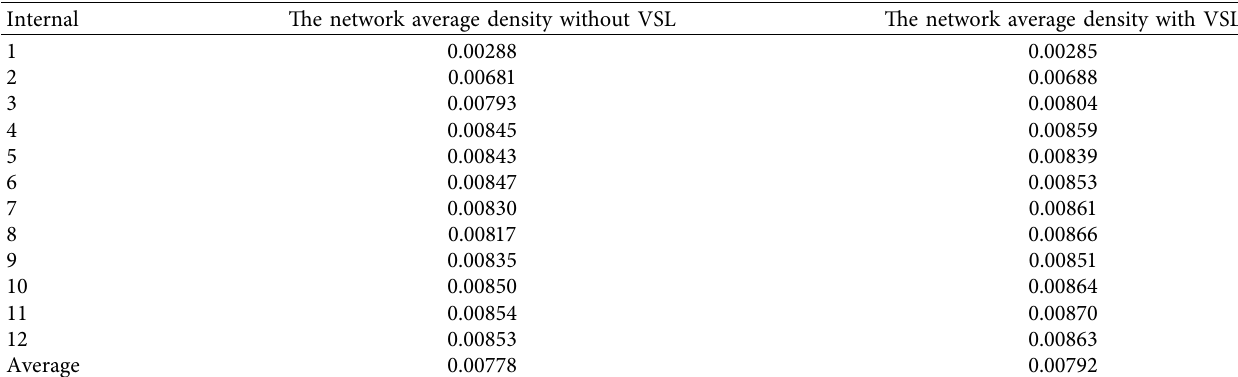
Table 4: Simulation results.